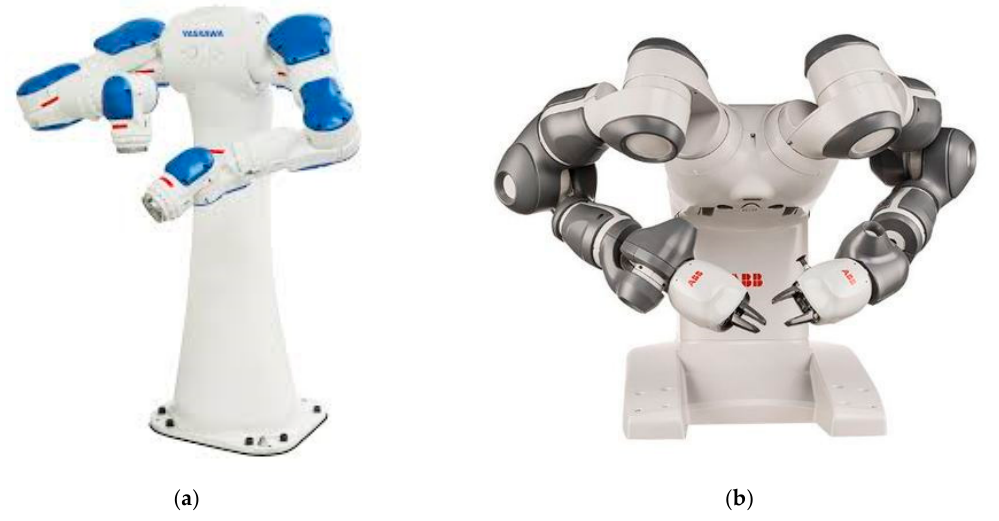
Figure 6. Robotic structure with two robotic arms: ( a ) Yaskawa type [12]; ( b ) ABB type [13].